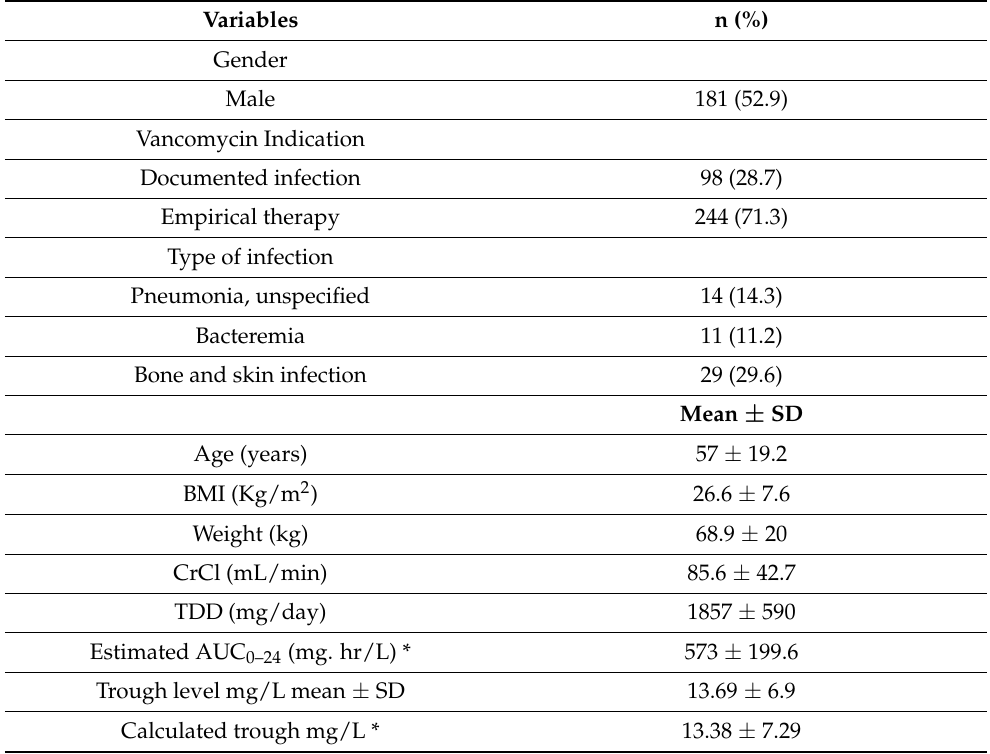
Table 1. Patient Demographics, Clinical Characteristics, Vancomycin Dose and Monitoring